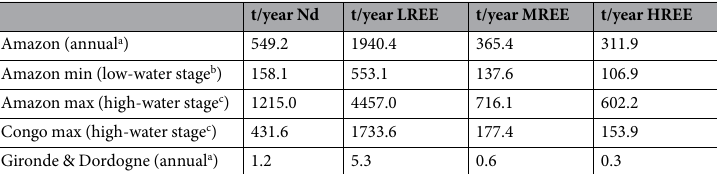
Table 1. Assessment of Nd, LREE, MREE and HREE inputs to the Atlantic seabed sediments supported by the calculated percent removals of Sholkovitz 24 using data from Barroux et al . 43 , Dupré et al . 28 , Gaillardet et al . 29 , and Martin et al . 31 . a Corresponds to average annual REE fluxes with respect to average annual discharge. b Corresponds to a one-year linear extrapolation considering the minimum REE input/discharge recorded during the low-water stage. c Corresponds to a linear extrapolation for one-year considering the maximum REE input/discharge recorded during the high-water